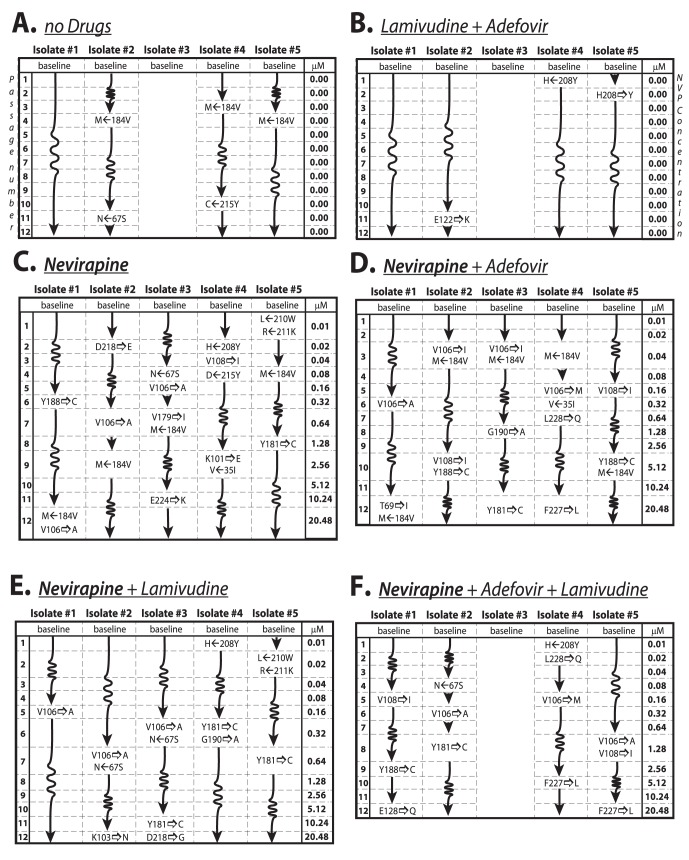
Summary of passage experiments with sequencing data.The illustration provides a complete review of RT sequence changes under the following experimental set-ups: A: no drugs were added to the media, B: [1 µM] 3 TC and [2 µM] ADV were added and maintained, C: NVP was added and concentrations were doubled for each passage (0.01 µM NVP during the first passage up to 20.48 µM during the last passage), D: [2 µM] ADV and increasing concentrations of NVP were added, E: [1 µM] 3 TC and increasing concentrations of NVP were added and F: [1 µM] 3 TC and [2 µM] ADV and increasing concentrations of NVP were added to the medium. Individual isolates #1 to #5 are indicated above the columns. Sequence changes listed are indicated in the rows that correspond to the passage number where they were first observed. NVP concentrations used in the respective passage experiment are listed on the right in units µM. Any mutation away from wild-type (Hxb2 strain) is indicated by a rightward-pointing arrow, whereas reversal to wild-type is indicated by a left-ward pointing arrow. All sequence changes (novel mutations and reversals) persisted throughout passage 12.